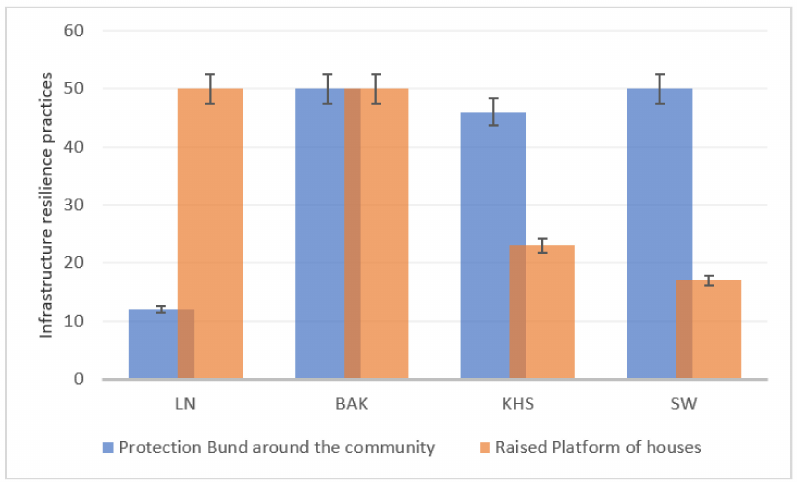
Figure 15. Infrastructure resilience practices in flood-affected communities in district